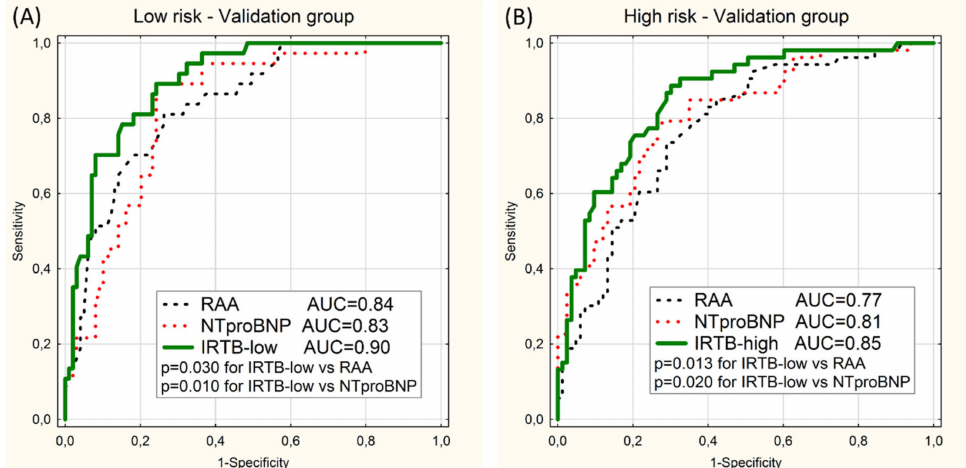
Figure 2. ROC curves for prediction of the low-risk category ( A ) and the high-risk category ( B ) in the validation group using 2 univariable models (RAA and NTproBNP) and the multivariable model (IRTB-low or IRTB-high). Values of area under curves (AUC) and p -values ( p ) are presented. Separate ROC curve analyses were performed on the subgroups of patient with PAH and CTEPH. When the validation group was limited to 57 of PAH patient (the PAH subgroup) the values of AUC